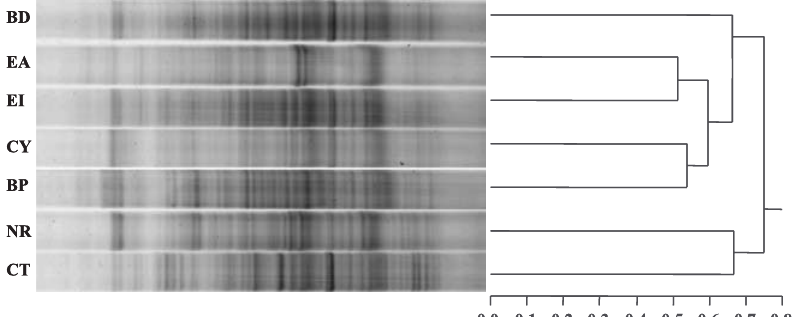
Figura 5. Estrutura das comunidades de bactérias com base nos perfis de fragmentos do rRNA 16S de solo rizosférico de plantas de crescimento espontâneo em sistema de “landfarming” de resíduos petroquímicos após DGGE. BP ( Bidens pilosa ), BD ( Brachiaria decumbens ), CY ( Cyperus sp.), EI ( Eleusine indica ), EA ( Eclipta alba ), NR (Solo não-rizosférico) e CT (Solo-controle sem